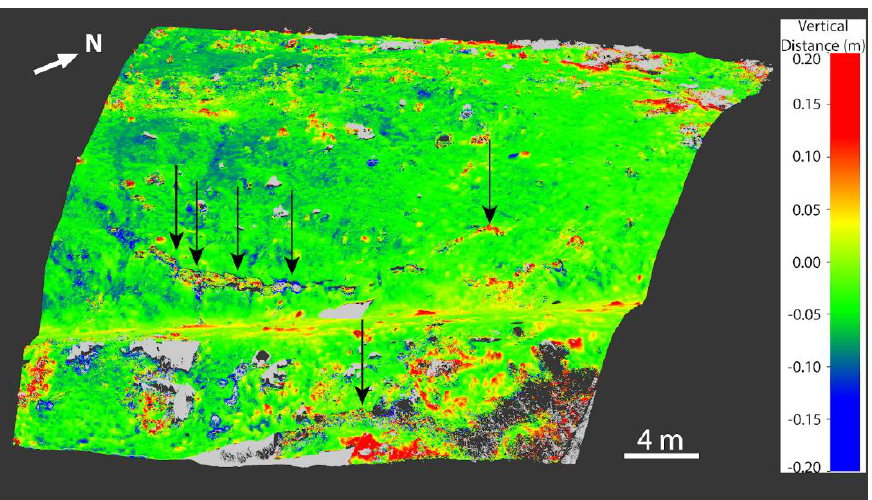
Figure 9. Differences between the October 2020 and the March 2021 UAV SfM – derived point clouds from Kechries site two. The eastern crack that was visible in the UAV – derived DSM comparison (see also Figure 5) is unclear, although the linear pattern of the point cloud differences could be interpreted as preliminary signs of displacement in a landslide scarp.